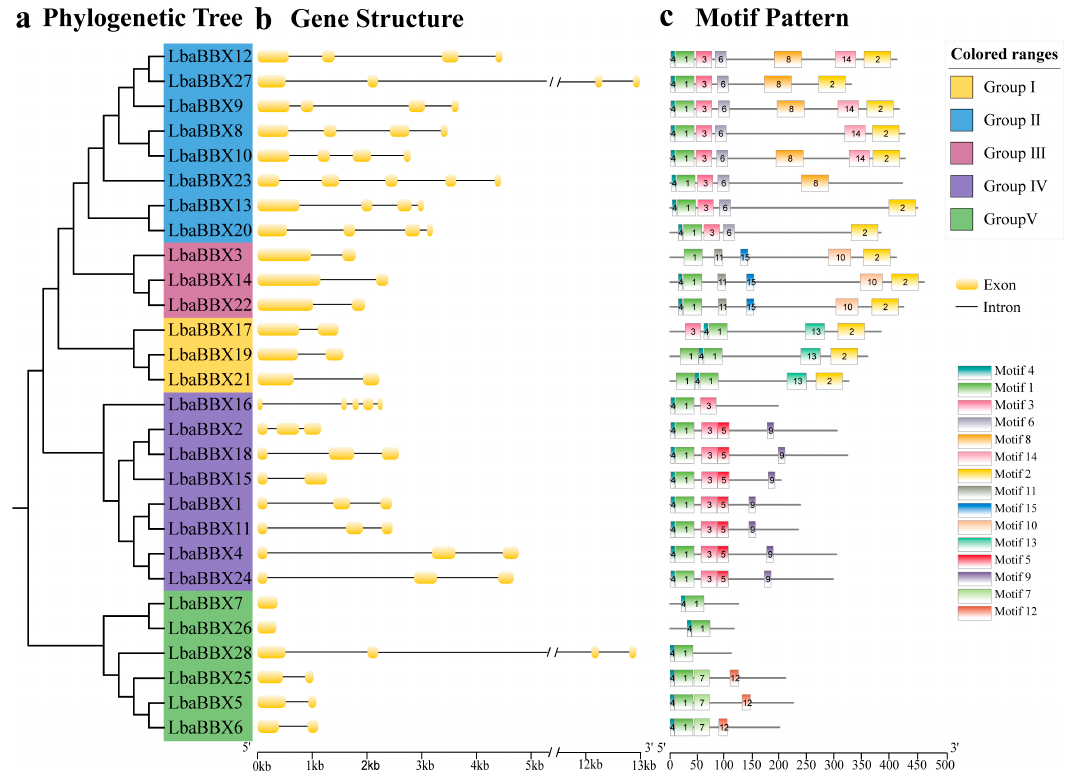
Figure 2. Phylogenetic relationships and motif composition of the LbaBBX proteins, and gene structure of the LbaBBX genes. ( a ) The phylogenetic tree was constructed based on the full-length se- quences using IQ-TREE software by maximum likelihood (ML) method and 1000 bootstrap repli- cates. ( b ) Exon/intron structures of BBX genes from wolfberry. The exons and introns are repre- sented by yellow boxes and black lines, respectively. The sizes of exons and introns can be estimated using the scale below. ( c ) The conserved motifs of wolfberry proteins were elucidated by MEME. The 15 motifs were displayed by the different colored rectangles. The sequence information for each motif is provided in Table S2. The length of protein can be estimated using the scale at the bottom.